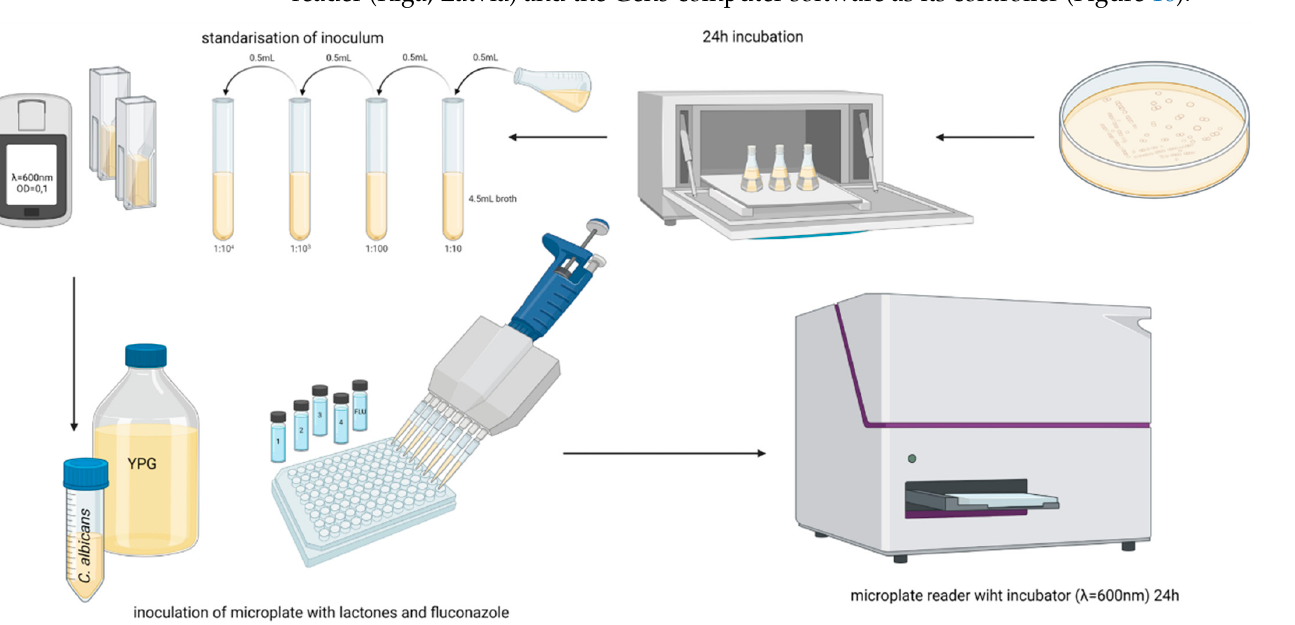
Figure 16. Schematic representation of the method for determination of biological activity. The standardized yeast inoculum was placed in a 96-well microplate containing the phthalide lactones at the quantified concentrations. After 24 h of incubation, the plates were placed in a microplate reader for optical density (OD) determination (Figure S-15a,b) (created in